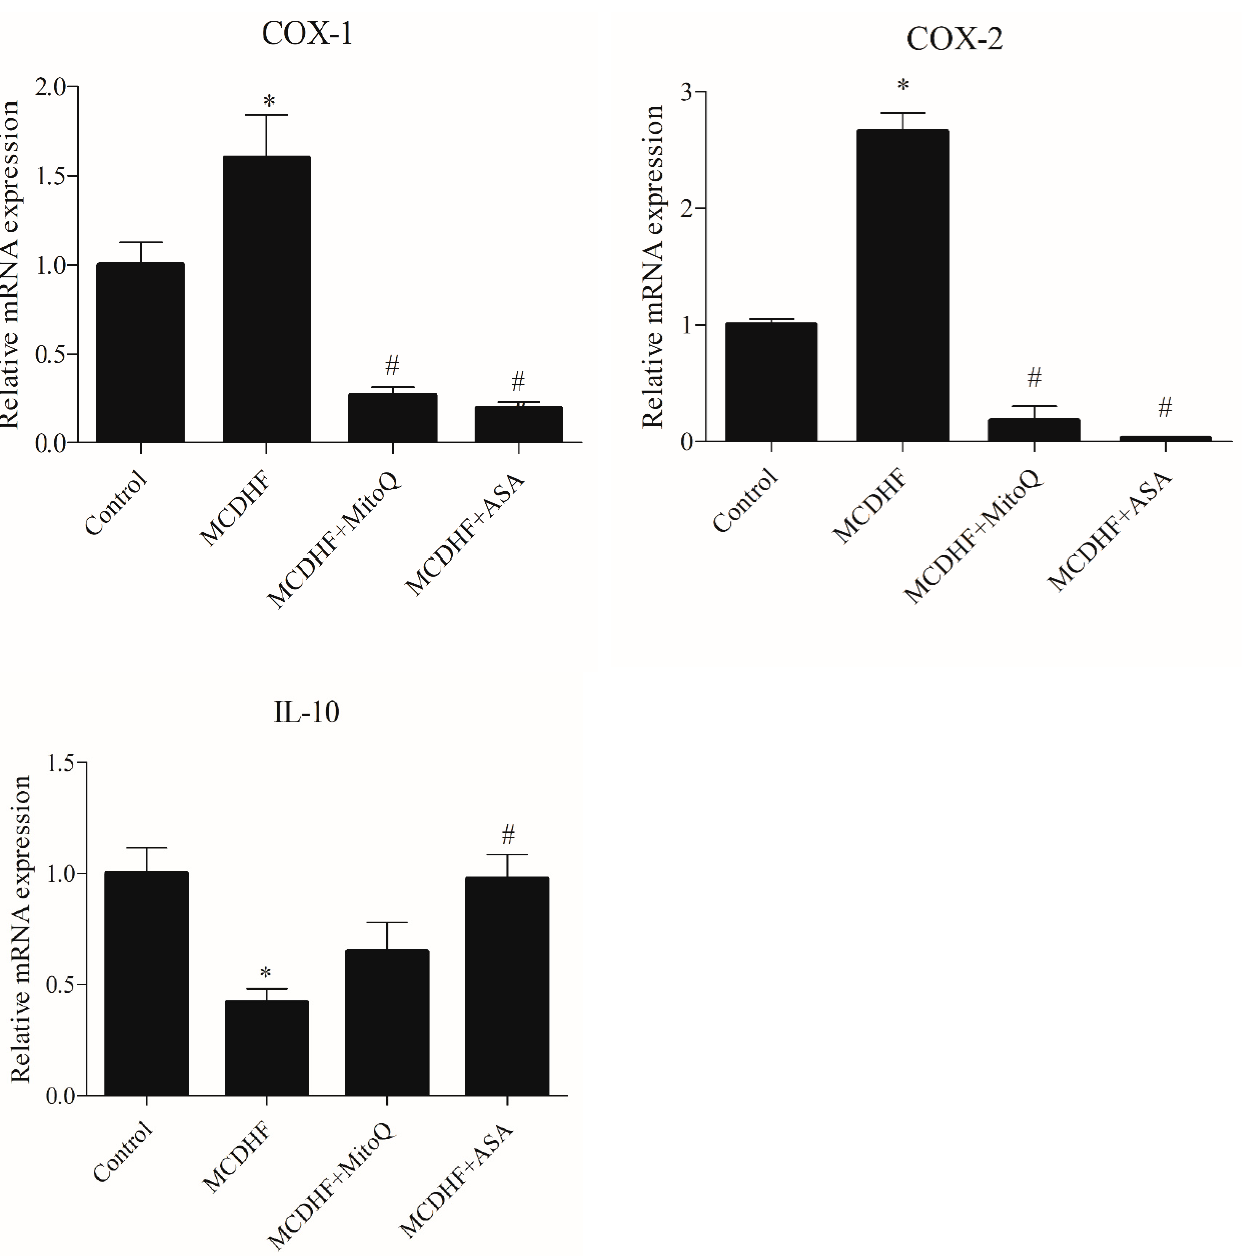
Figure 2. mRNA expression of IL-6, IL-1 β , TNF α , Serpinb3, COX-1, COX-2, and IL-10 in livers from control, MCDHF, MCDHF + MitoQ, and MCDHF + ASA mice. * p < 0.05 vs. control; # p < 0.05 vs. MCDHF. The expression of proinflammatory cytokines TNF α , IL-1 β , IL-6, Serpinb3, COX-1, and COX-2 was higher in MCDHFD mice compared to controls. Treatment with MitoQ and ASA determined a significant decrease in TNF α , IL-6, Serpinb3, COX-1, and COX-2 expression. Anti-inflammatory cytokine IL-10 expression was reduced in MCDHFD mice; treatment with ASA restored its levels in MCDHFD animals.